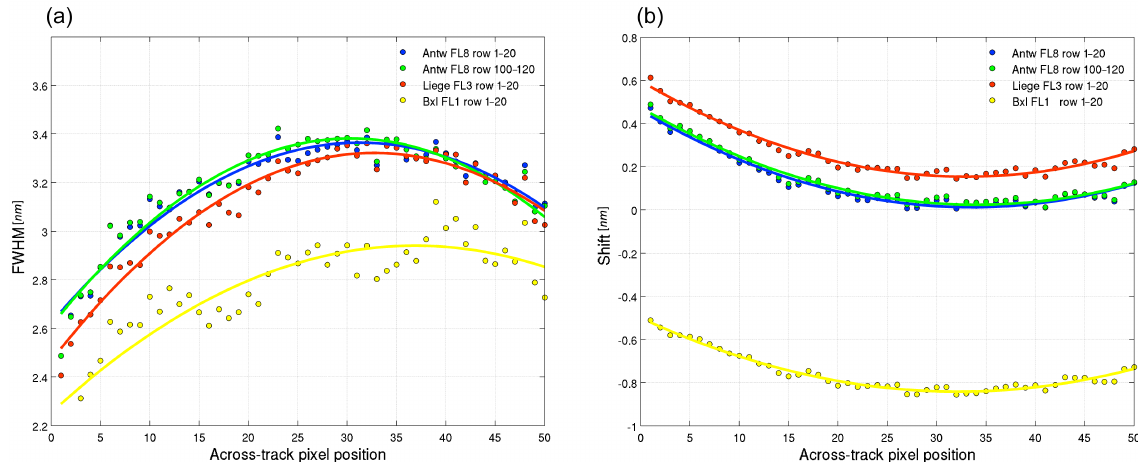
Figure 6. In-flight spectral calibration: (a) the spectral resolution (FWHM) and (b) the spectral shift and its dependency on the across-track scan line pixel position (spectral smile) plotted for 490nm, i.e. the middle of the analysis window, for different flight lines. A second-order polynomial has been fitted to each calibration set.